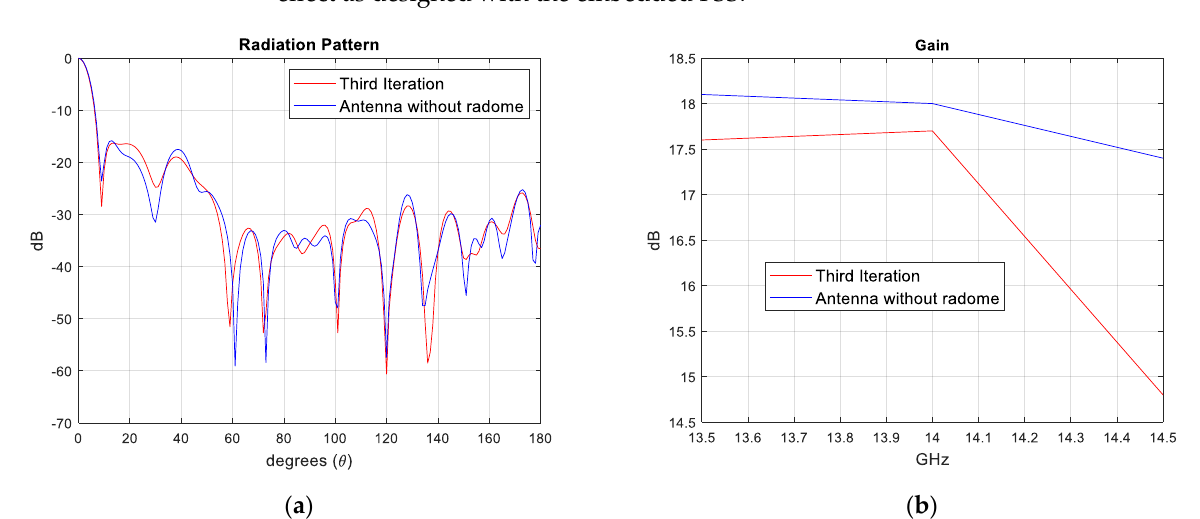
Figure 8. ( a ) Radiation pattern results considering the radome with the antenna and compared with the antenna alone; ( b ) frequency sweep around the resonant frequency considering the radome with the antenna and the antenna alone, showing the frequency filtering characteristics of the embedded FSS.